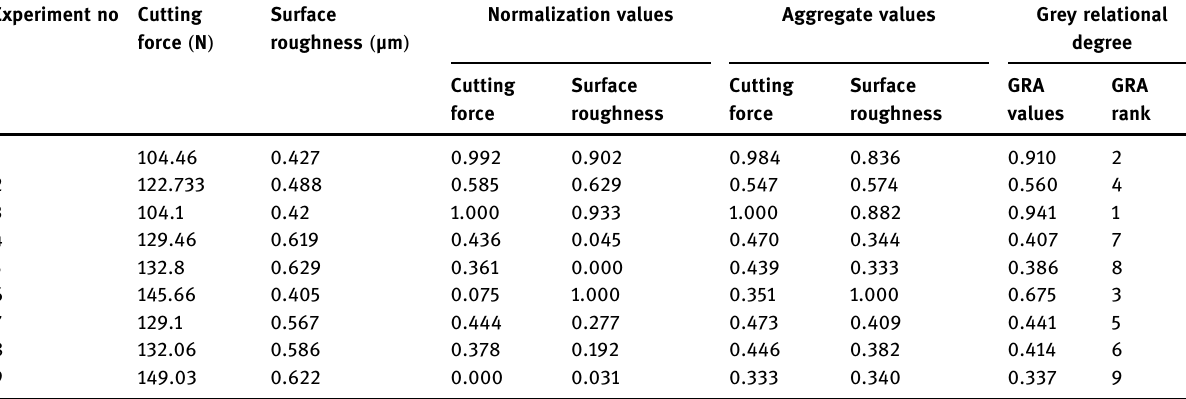
Table 4: Normalized data, delta values, and grey relational grade for conventional insert tool Experiment no Cutting